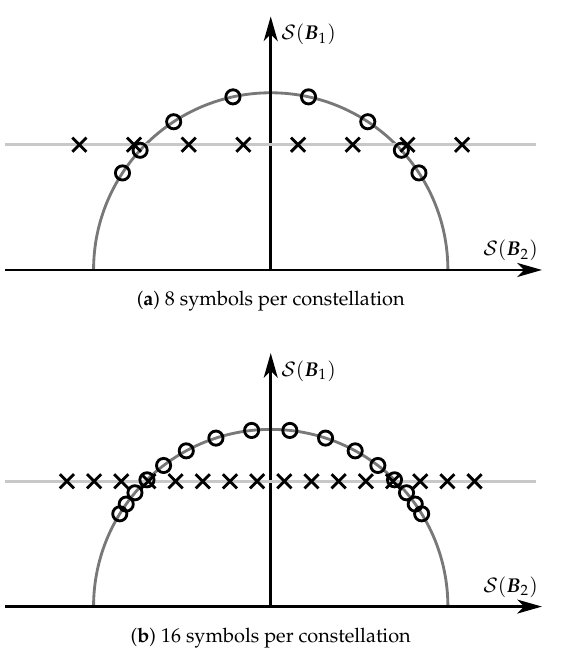
Figure 3. Two-dimensional graphical representation of the elements of a PSAM (with ‘ × ’ symbols) and the equivalent USTM (with ‘ ◦ ’